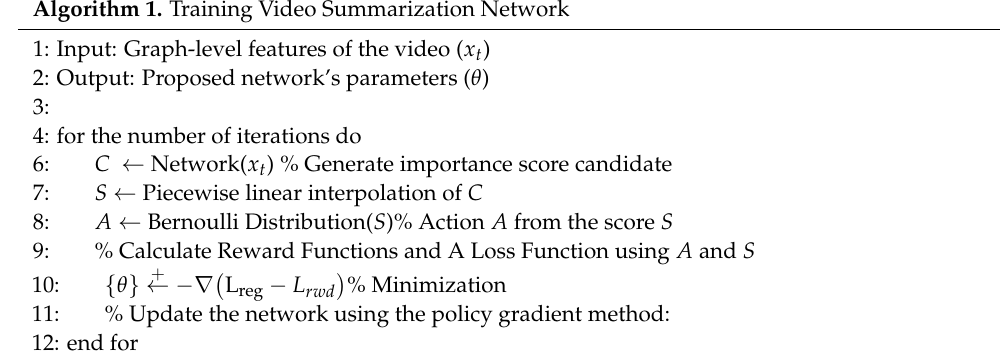
Algorithm 1 applies to the training procedure of the proposed video summarization network with the policy gradient method. Algorithm 1. Training Video Summarization